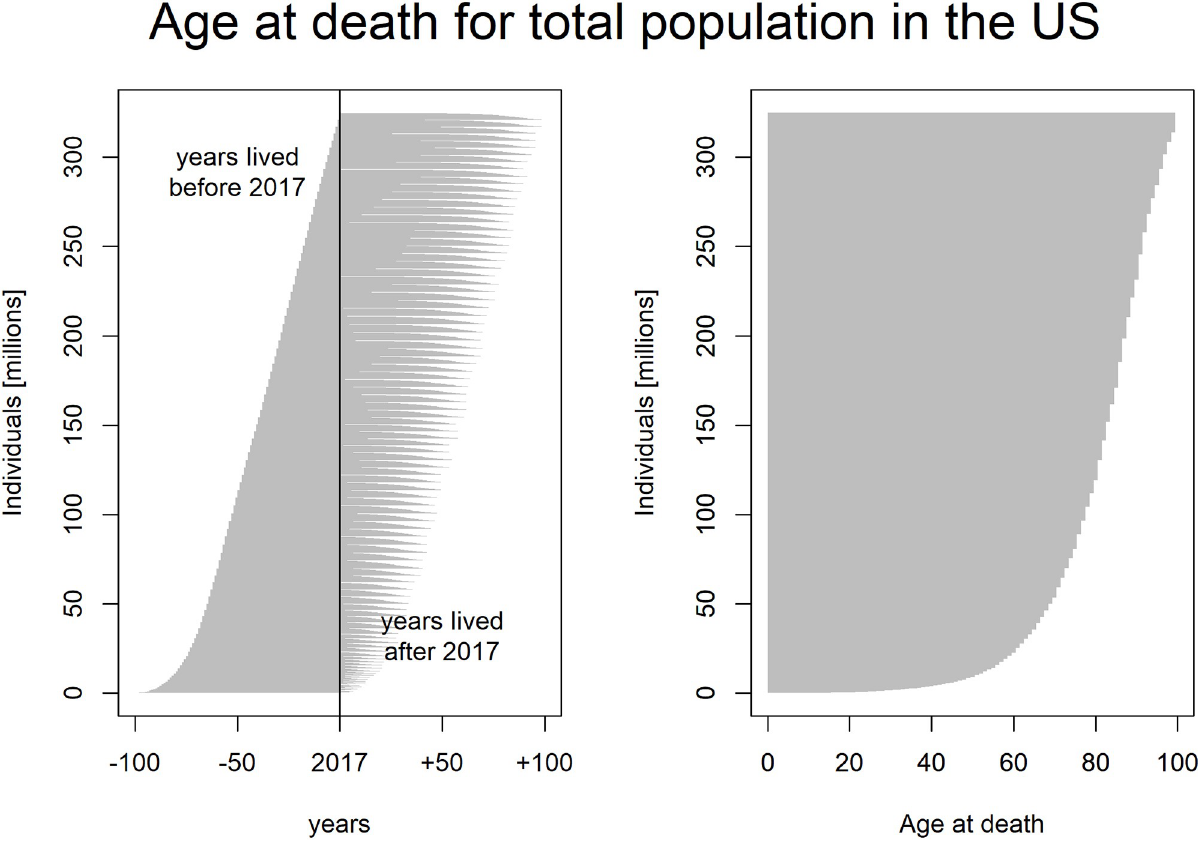
Fig 1. Estimated distribution of Age at Death (AD) for the total US population (2017). Left panel: Distribution by age. On the x-axis, -100 corresponds to the year 1917, and +100 corresponds to the year 2117. Years lived before 2017 are observed, whereas years lived after 2017 are expected. Right panel: Distribution by